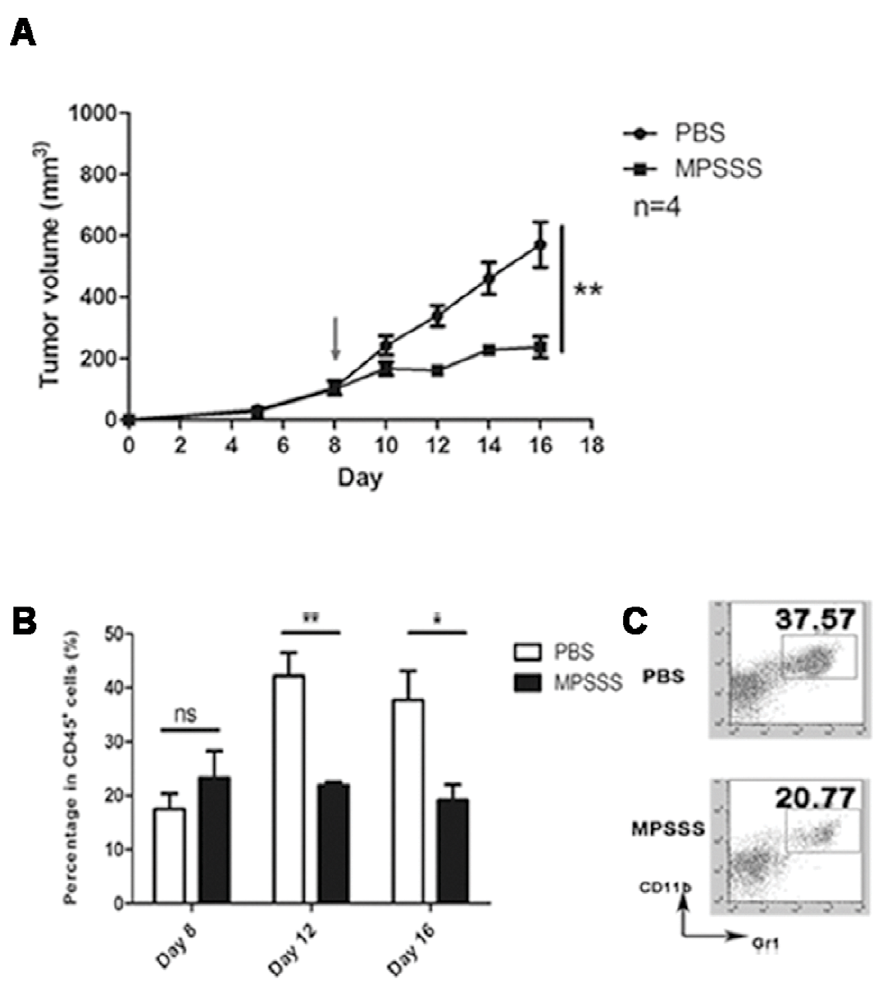
Figure 2. MPSSS inhibited tumor growth and reduced MDSC numbers. (A) C57BL/6 mice were injected subcutaneously with 1 6 10 6 McgR32 cellsand 8 day later, with MPSSS or PBS intraperitoneally once every two days. Tumor volume was recorded as the mean 6 SD and each group contained 3–4 mice and was analyzed by one-way ANOVA for repeated measures data. (B) At the indicated days after tumor cell injection, peripheral blood was taken for MDSC detection by flow cytometry, Quantitative data are expressed as mean 6 SD and analyzed by Student’s t tests. * P , 0.05, ** P , 0.01. (C) A representative flow cytometry analysis was shown for the staining of CD11b and Gr1.